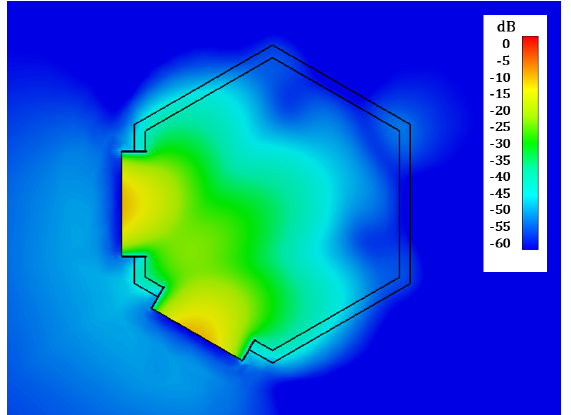
Figure 4. Simulated joint E-field distribution into the transverse plane of the horn antennas at 0.8 GHz. No ID.